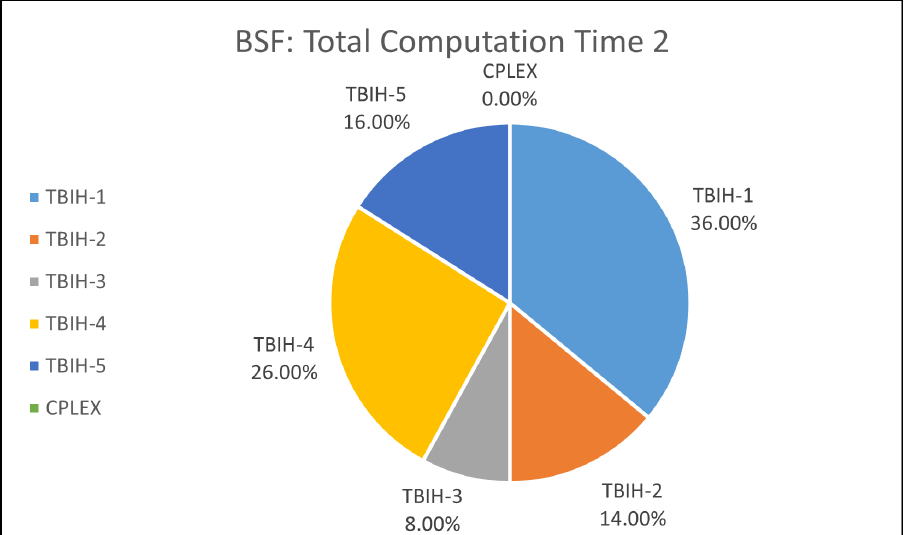
Figure A26. Algorithms performance compared to matheuristic rollout applied in PDS-RA: total BSF measured for total computation time over all test instances applied (including 10 non-benchmarked measurements).